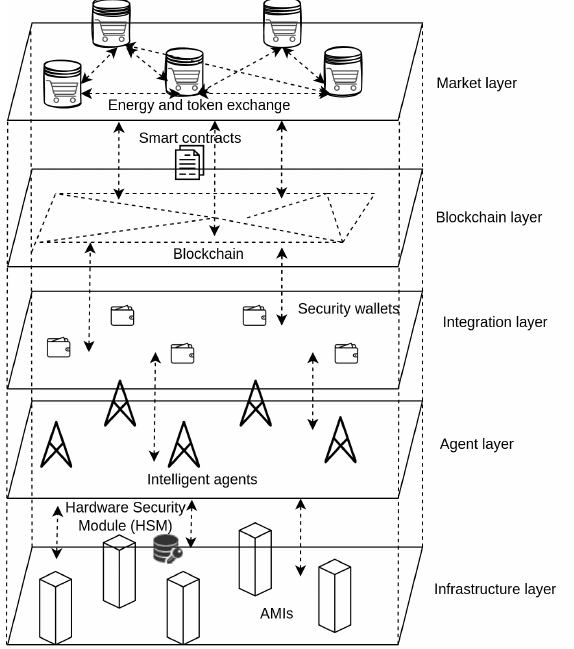
Figure 1. Overview of the